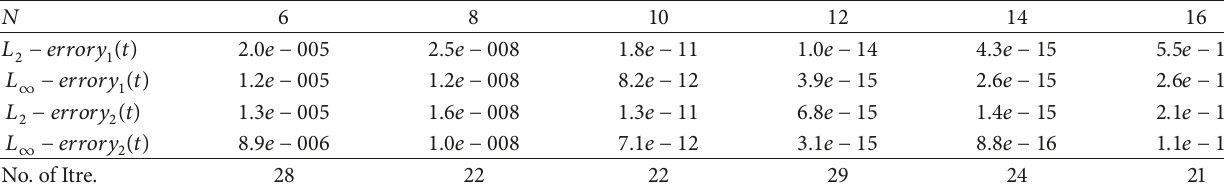
Table 2: The 𝐿 2 and 𝐿 ∞ errors for Example